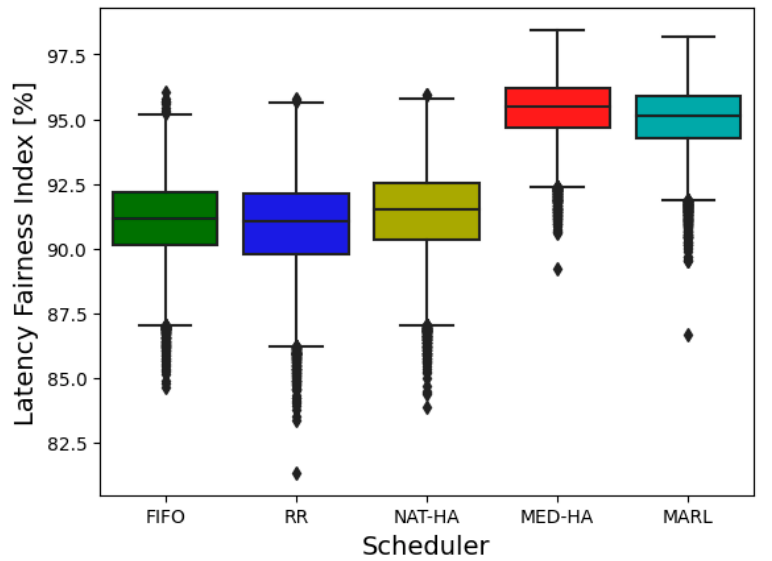
Figure 17. Box plot of latency fairness index per scheduler from 10,000 episodes in topology 4 with the random flow.